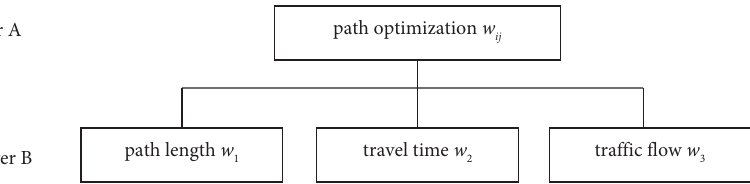
Figure 2: Te layering diagram of path